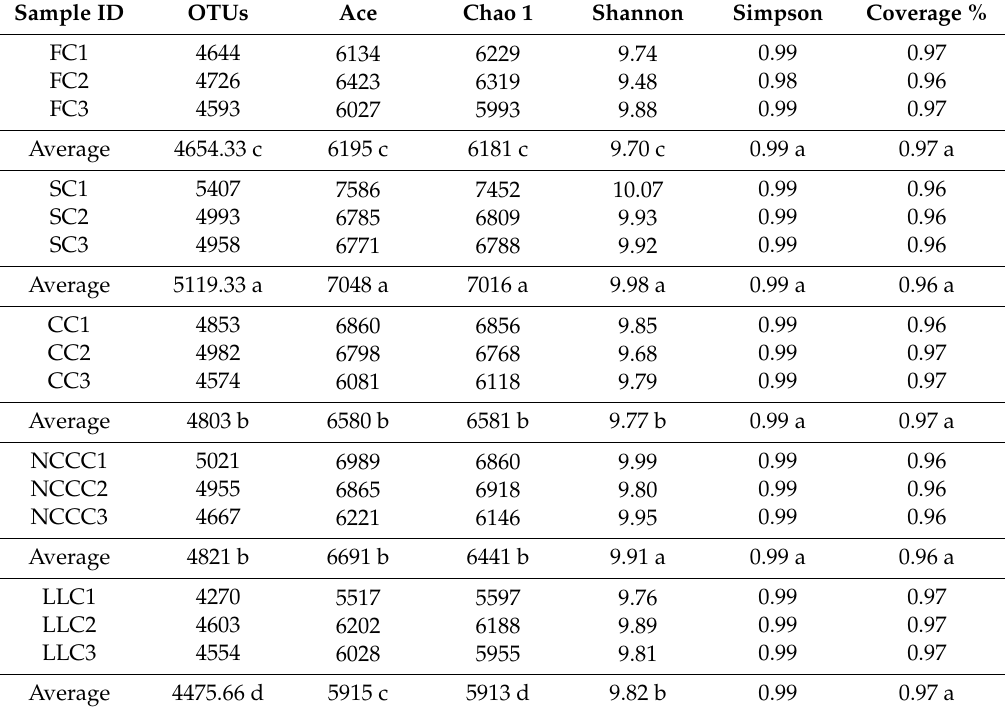
Table 4. Characterization of soil bacteria richness and diversity indices in di ff erent cropping treatments under plastic greenhouse vegetable cropping (PGVC)